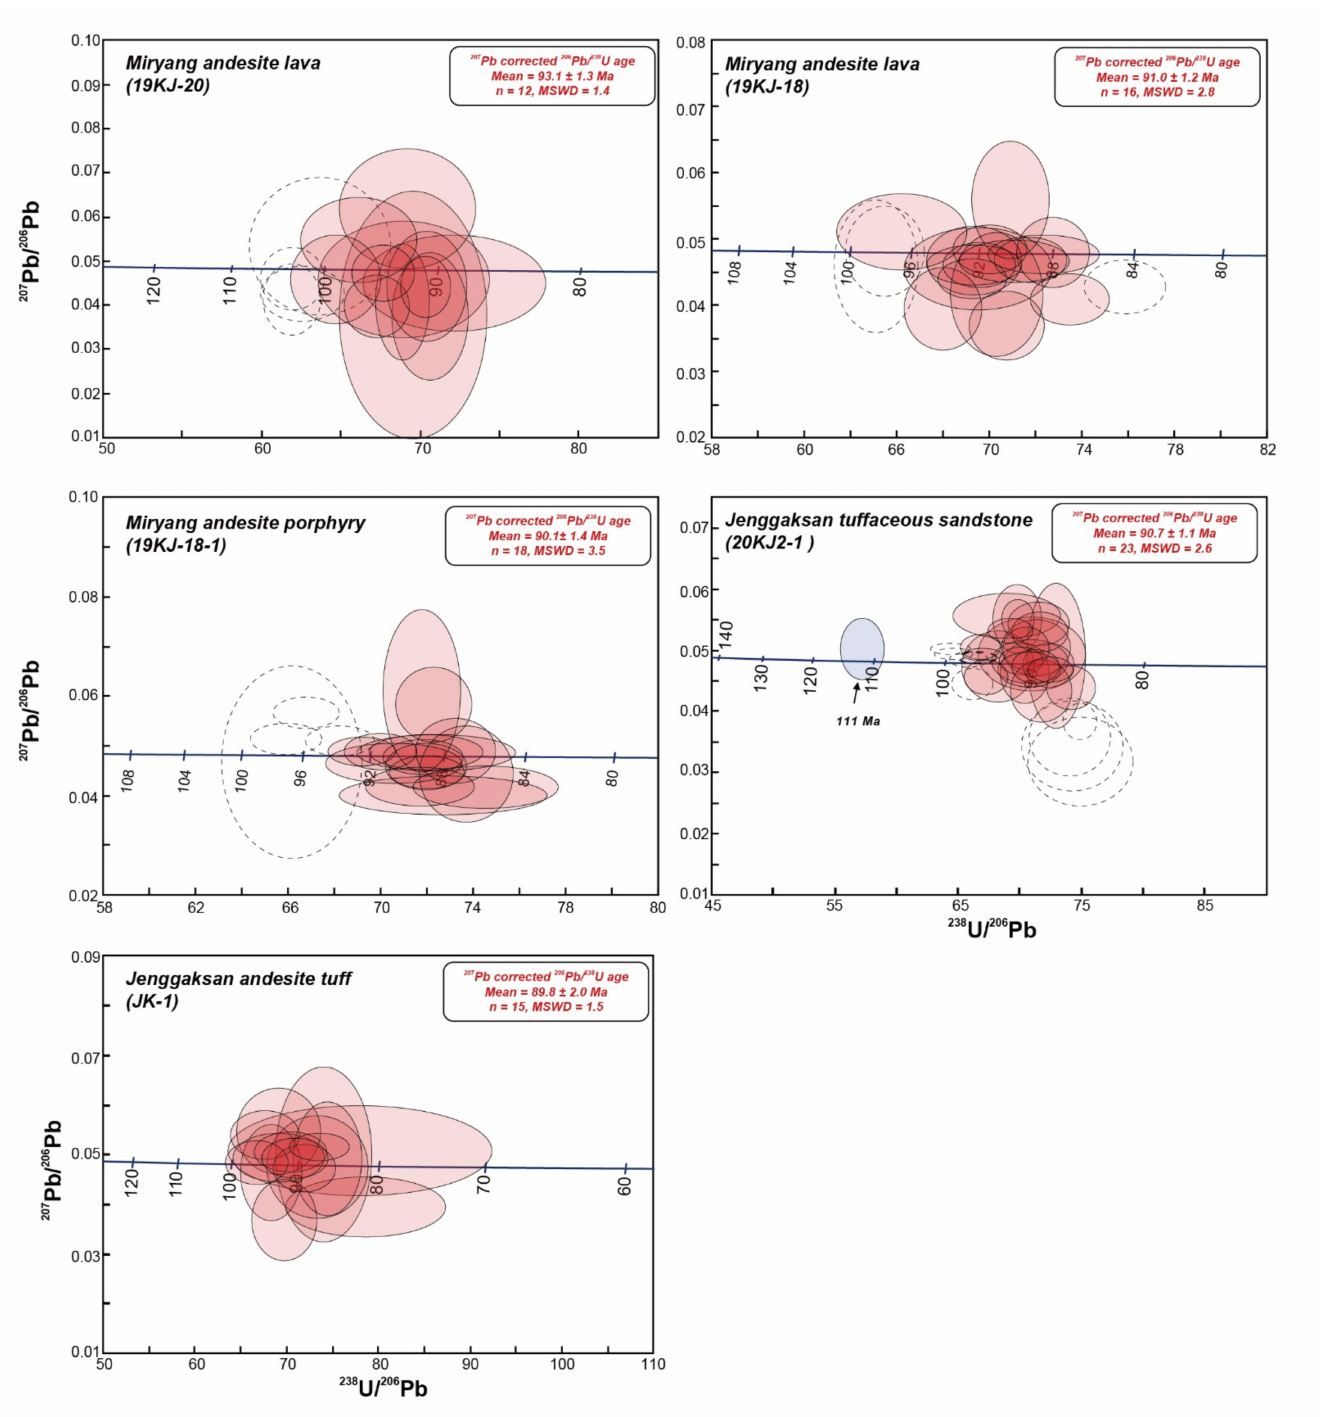
Figure 20. Terra–Wasserburg diagrams for the Miryang andesitic rocks (19KJ-20, 19KJ-18, and 19KJ-18-1), Jeonggaksan tuffaceous sandstone (20KJ2-1), and Jeonggaksan andesite tuff (JK-1). Dashed ellipses are the rejected data by weighted mean age